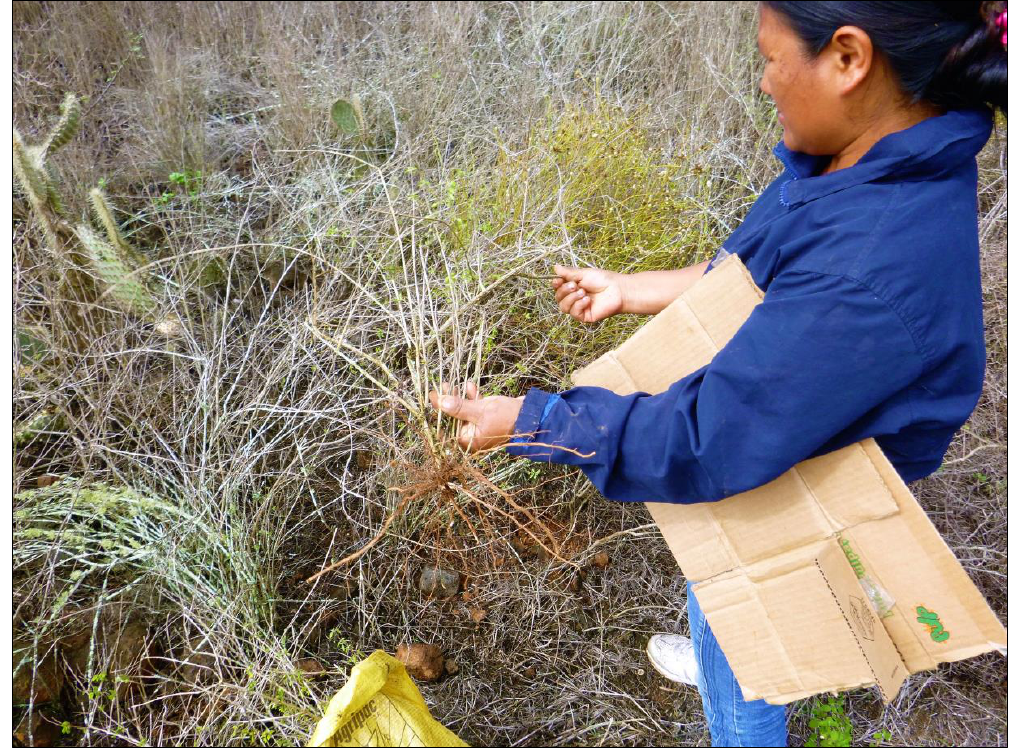
Figure 3. Parsing species. Photo by author.